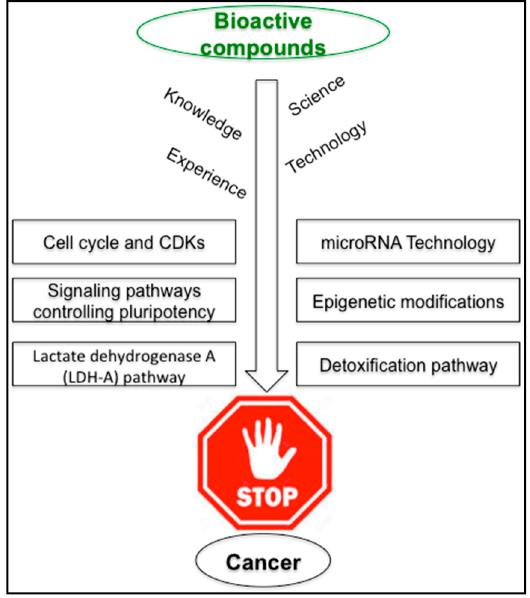
Figure 2. The mechanisms used by bioactive nutrients to reduce cancer risk.